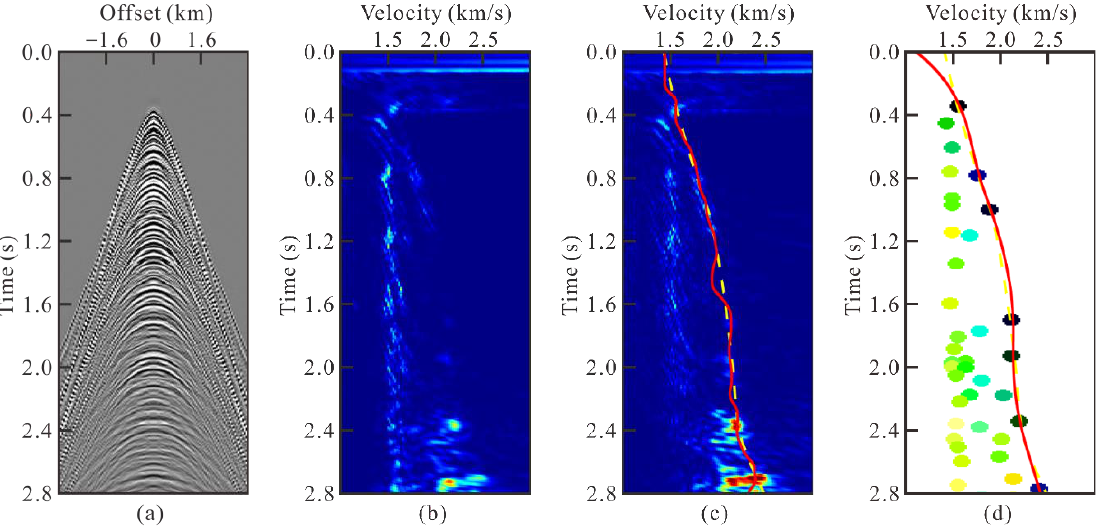
Figure 8. Application on a single CMP gather from the field data: ( a ) CMP record of original data, ( b ) velocity spectra of original data, ( c ) velocity spectra and velocity curve of the control group, in which the red solid line is automatically obtained, and the yellow dotted line is the reference velocity, ( d ) velocity spectra and velocity curve obtained by the method proposed in this paper, in which the red solid line is automatically obtained, and the yellow dotted line is the reference velocity.